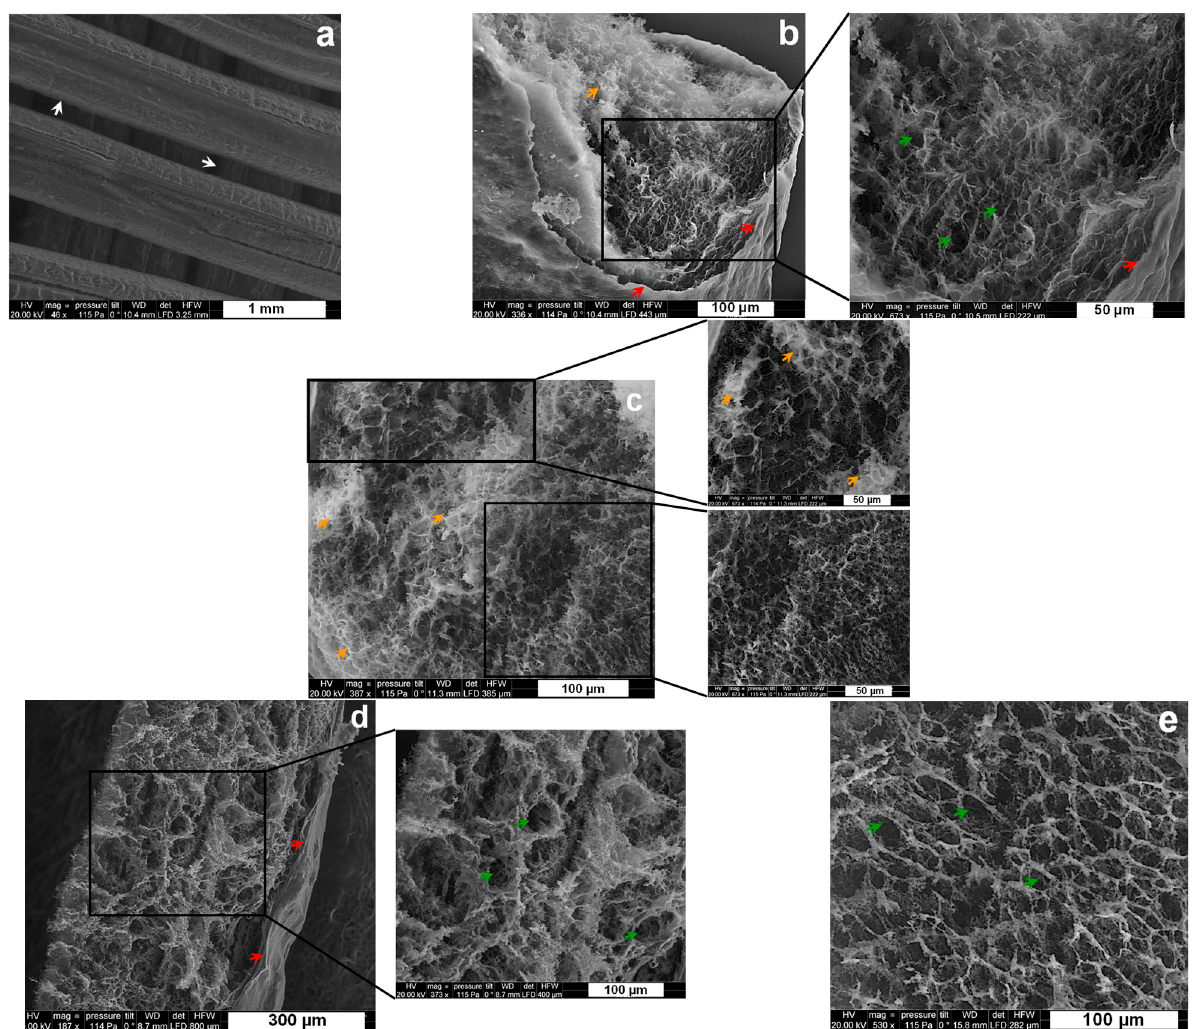
Figure 4. SEM micrographs of 3D printed hydrogel scaffolds after freeze drying. ( a – c ) CHI2/CNF0.2 with entrapped cellulase: ( a ) overview of the surface of the filaments in the different sublayers of the scaffold; ( b , c ) filament cross-section surface at different magnifications, showing an inner spongy-like network of the filament covered by a skin-like shell (Red arrows) at the outer surface. ( d , e ) CHI2/CNF0.2 reference scaffold without cellulase: filament cross-section surface at different magnifications, also showing an inner spongy-like network of the filament covered by a skin-like shell (Red arrows) at the outer surface. Arrows: White: borderline of filaments printed in different scaffold sublayers; Red: skin-like shell structure of the outer surface of the filaments; Green: pores distributed in the whole inner microstructure of the filaments; Orange: brightness spots probably related to some remaining salt, such as the sodium acetate, formed after mixing chitosan-acetate and sodium-caseinate to prepare the chitosan–caseinate PEC